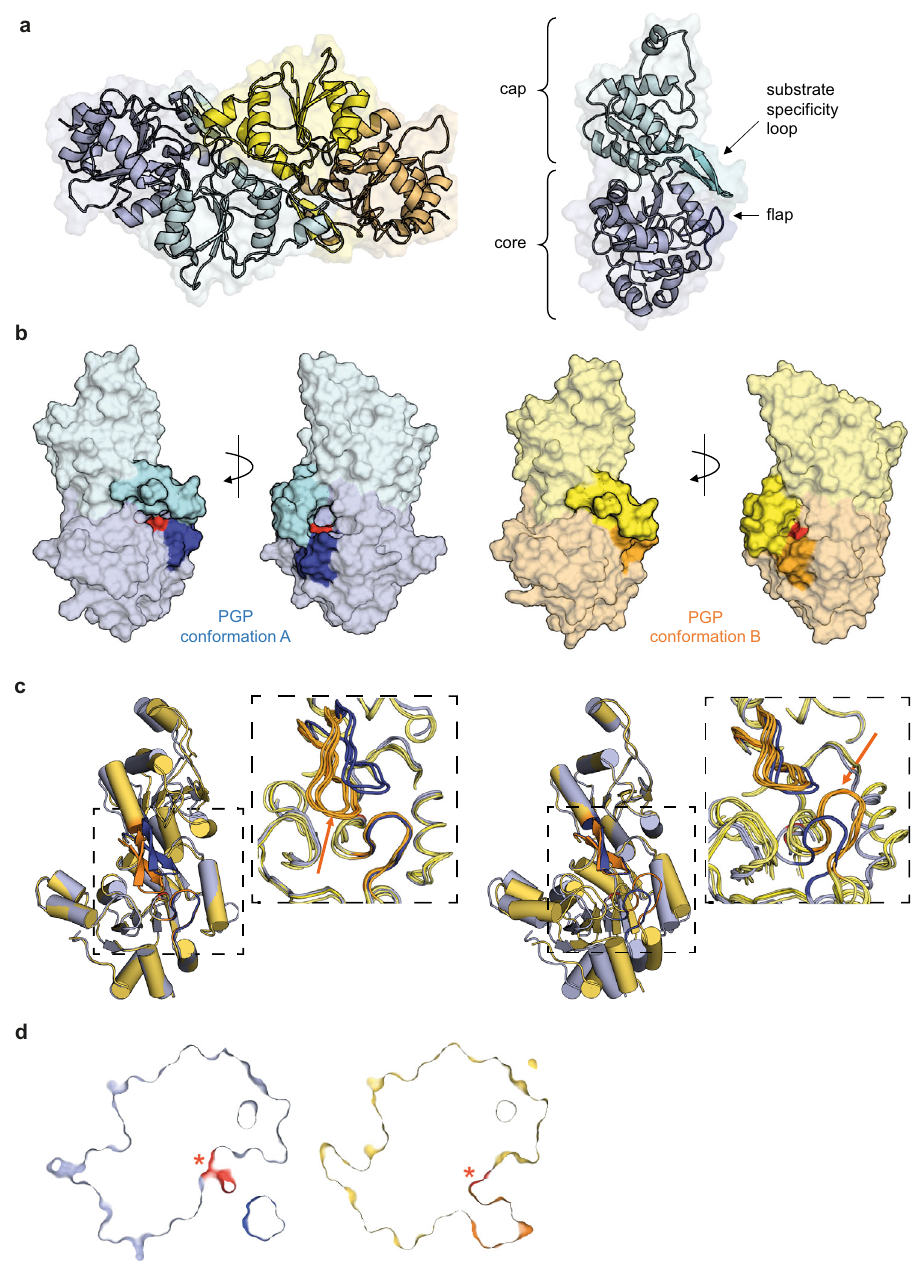
Fig. 2 | Observation of open and closed active site conformations in apo-PGP. a Left,X-raycrystalstructureofhomodimeric,full-lengthmurinePGP D34N/C297S (apo- PGP; chain E in blue-green, chain F in yellow-gold), re fi ned to a resolution of 2.3Å (PDB code 7PO7). Right, ribbon representation of chain E; important structural features are indicated. b Alignment of the catalytic core domains of apo-PGP monomers. Left, surface representation of chain E (labeled in blue-light blue). Right, surface representation of chain A (labeled in yellow-gold). The substrate speci fi city loops are marked in turquoise and bright yellow, the fl ap domains are labeled in dark blue and orange, and the catalytic aspartate (Asn34 in apo-PGP) is shownin red. In chain A the capdomain isrotatedrelative to chain E,resulting in a shiftofthesubstratespeci fi citylooptowardsthecatalyticcore.Theviewsdifferby a 180° rotation as indicated. c Superposition of apo-PGP monomers (chain A in